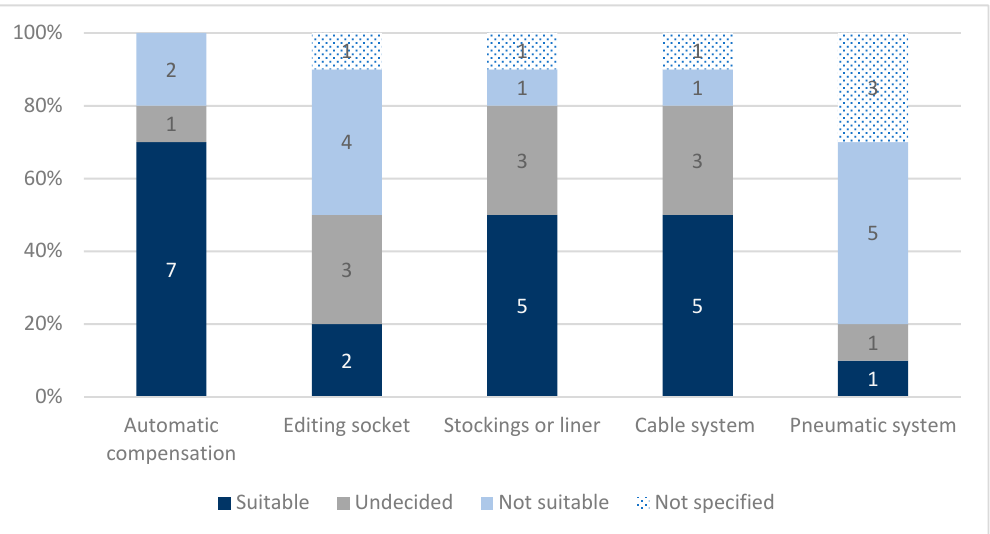
Figure 6. The assessment of techniques to compensate residual limb volume fluctuations.